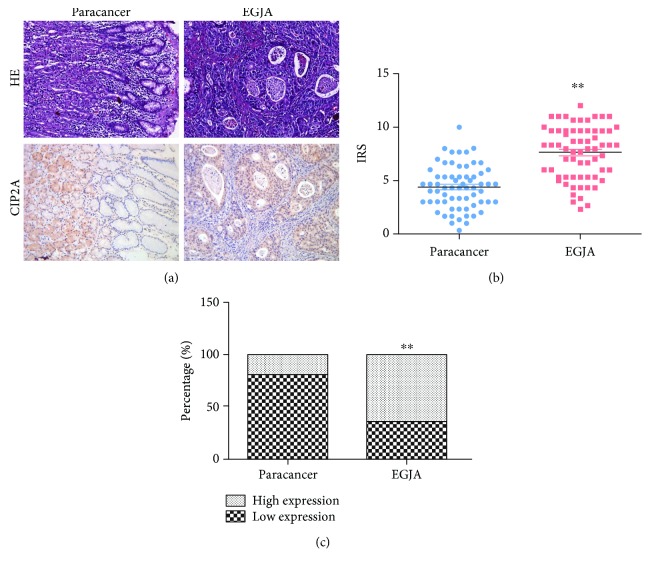
The expression of CIP2A in EGJA. (a) Hematoxylin-eosin (HE, upper) and immunohistochemistry (IHC, lower) staining of paracancer (left) and esophagogastric junction adenocarcinoma (EGJA, right). (b) Immunoreactivity score (IRS) comparison of CIP2A between paracancer and EGJA (Wilcoxon's test, ∗∗P < 0.01). (c) Expression percentage comparison of CIP2A between paracancer and EGJA (Fisher's exact test, ∗∗P < 0.01).